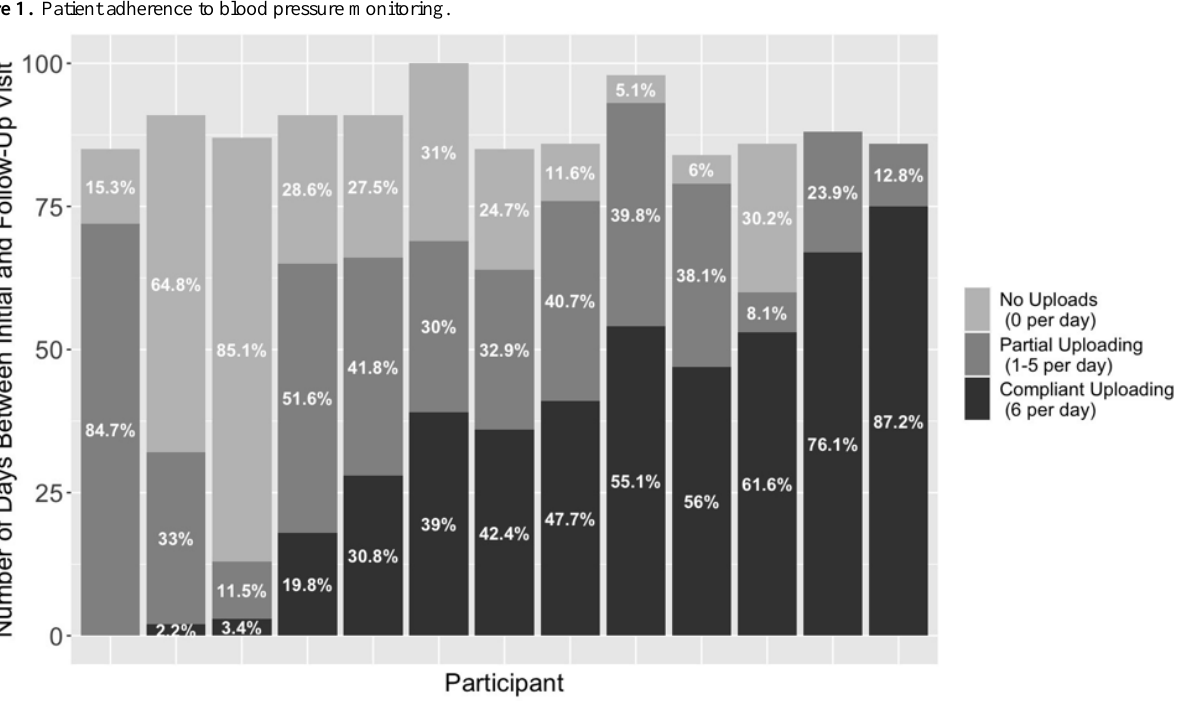
Figure 1. Patient adherence to blood pressure